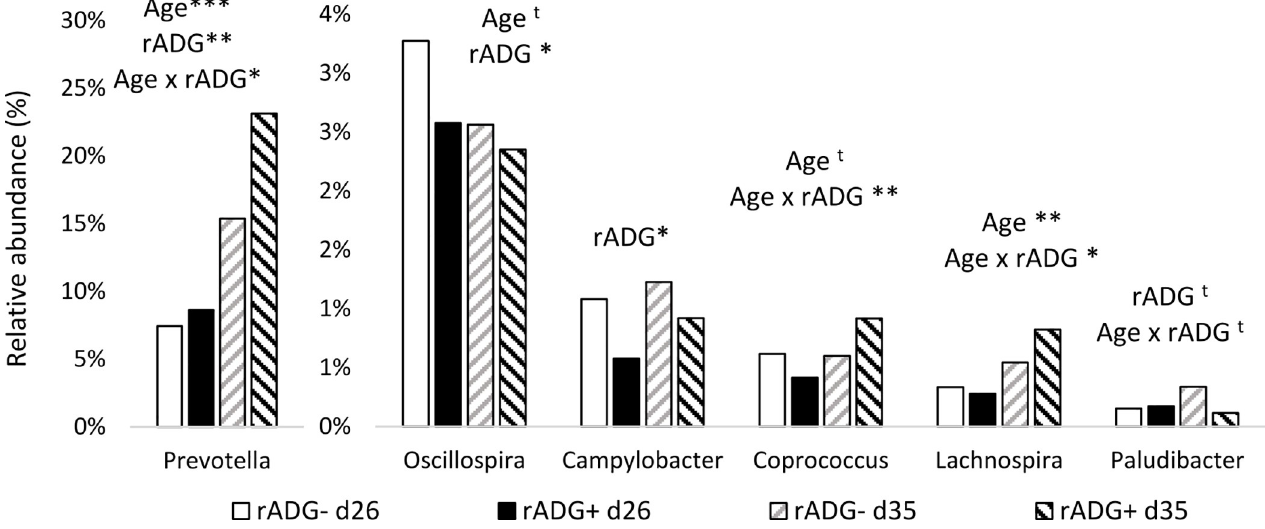
Fig 5. Relative abundances of significant genera and families between pigs with high or low post-weaning growth. Fecal samples were collected from piglets at 26 (222) and 35 days of age (254). Piglets were classified according to their relative ADG (rADG) between d26 and d48 into high (rADG+) or low (rADG-) growth classes and the 20% pigs showing a median rADG were excluded. For each taxon trends and significant effects of age rADG class and their interaction are indicated. ��� (P < 0.001) �� (P < 0.01) � (P < 0.05) and t (P < 0.1).